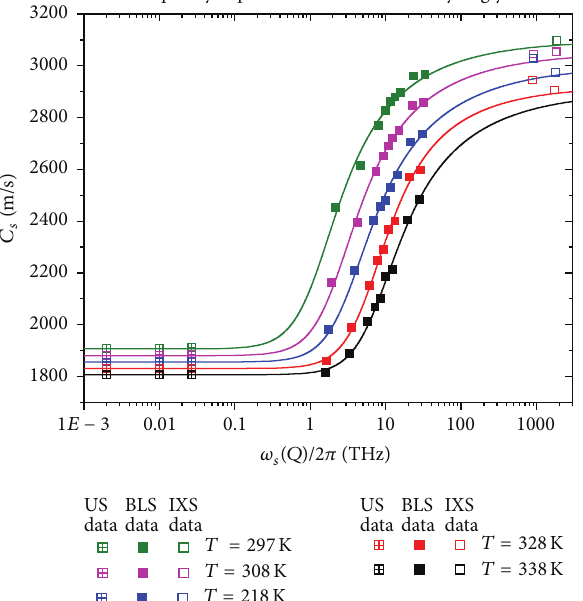
Figure 3: The sound velocity of glycerol measured at different frequencies by the spectroscopic techniques and at the sample temperatures indicated in the legend (from